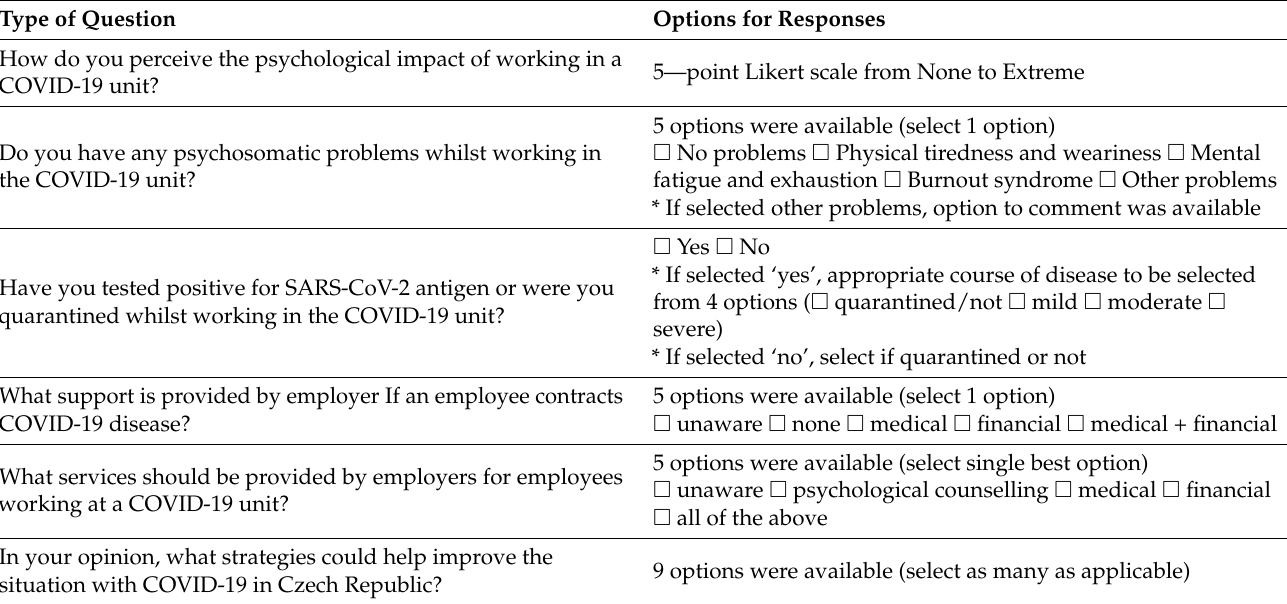
Table 1. Sample questionnaire outlining second part of